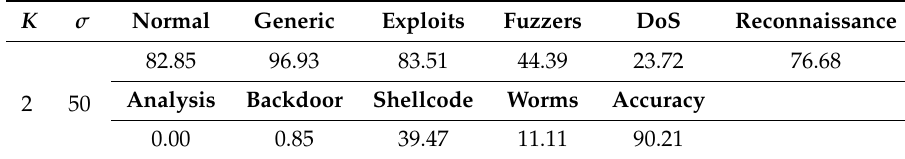
Table 6. Detection accuracy (%) with optimal parameters K and σ for UNSW-NB15 dataset.